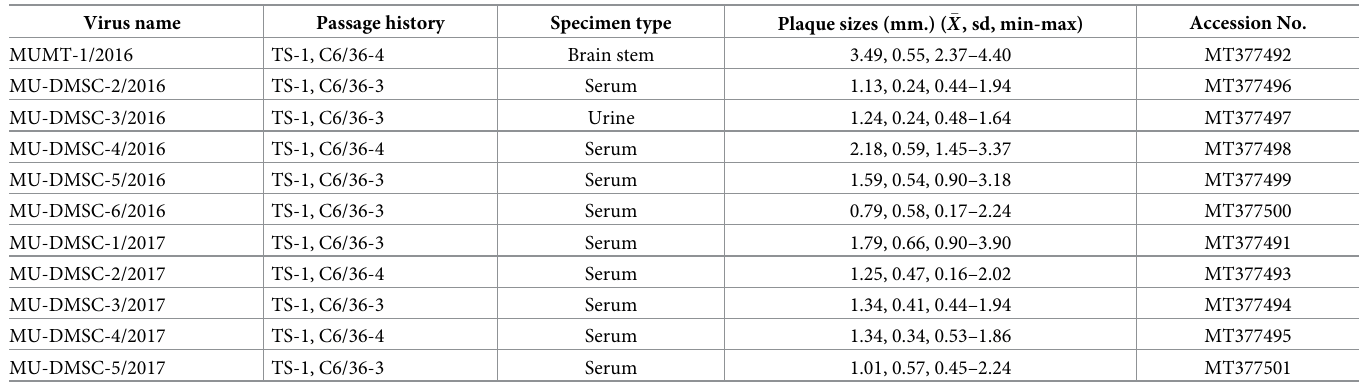
Table 1. Plaque size of Zika virus isolates in 1.5% CMC.